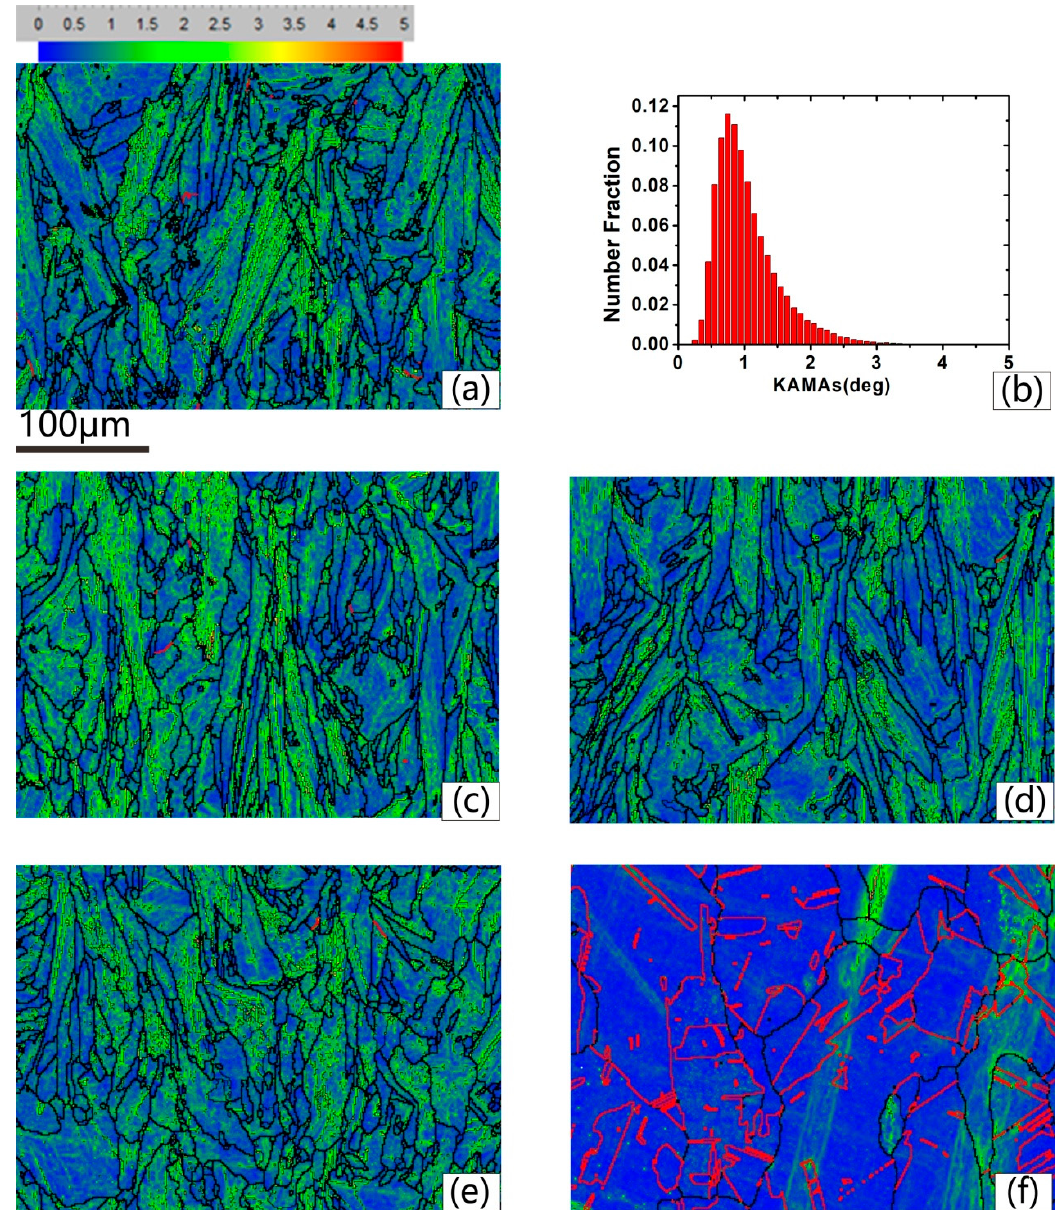
Figure 7. Kernel average misorientation angles (KAMAs) distribution and <111> 60° annealing twins boundaries distribution under different conditions: ( a ) As-deposited condition, ( b ) number fraction (NF) of KAMAs under as-deposited condition, ( c ) 980 °C, ( d ) 1030 °C, ( e ) 1080 °C, ( f ) 1130 °C.